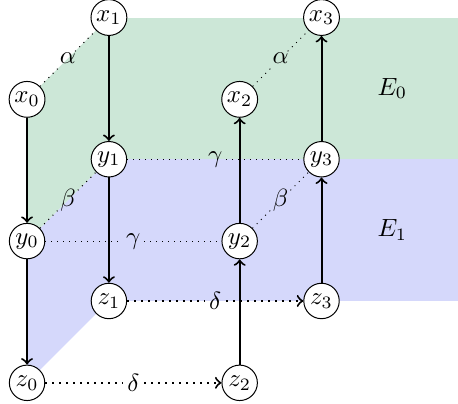
Figure 1: Outline of a basic boomerang